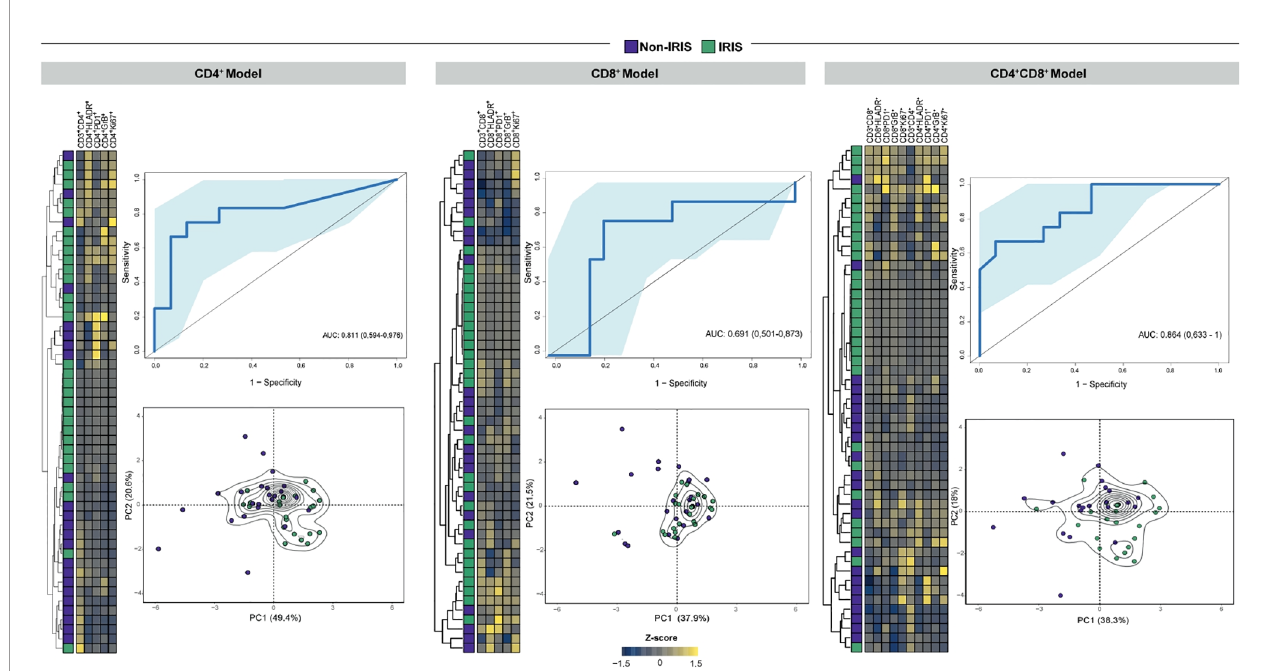
FIGURE 6 | Combination of T cell activation markers to diagnose IRIS after ART initiation. In order to create diagnostic models that distinguish TB-IRIS from non- IRIS patients after ART initiation, unsupervised machine learning techniques were employed for either CD4 + or CD8 + T cell activation markers. In addition, a model encompassing both CD4 + and CD8 + T cell activation markers was also created. For each model, unsupervised cluster analyses (Ward ’ s method) and principal component analyses were employed. In order to estimate the accuracy of these models in discriminating patients, a receiver-operating characteristic curve analysis was